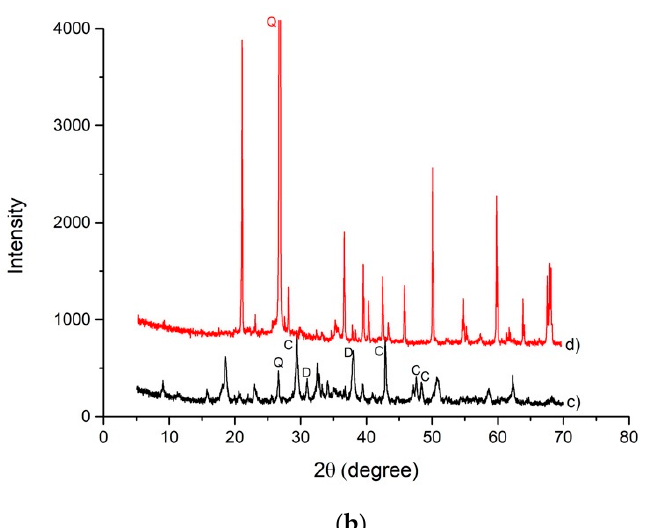
Figure 6. ( a ) XRD patterns of Slag A a) and Slag A after acid attack b) (C = calcite, Q = quartz, D = dolomite). ( b ) XRD patterns of Slag R c) and Slag R after the acid attack d) (C = calcite, Q = quartz, D = dolomite).